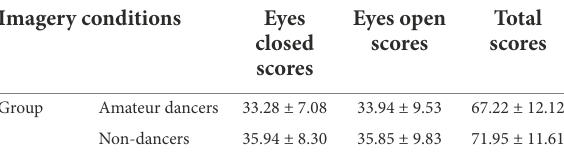
TABLE 1 Mean VVIQ scores for eyes closed and open conditions (M ± SD). Imagery